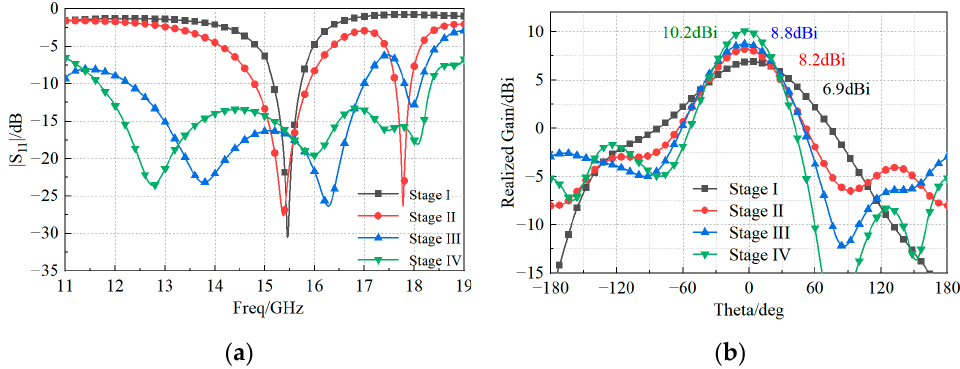
Figure 3. Simulated ( a ) magnitude of the reflection coefficient and ( b ) gain pattern at the four stages of the antenna design shown in Figure 2.